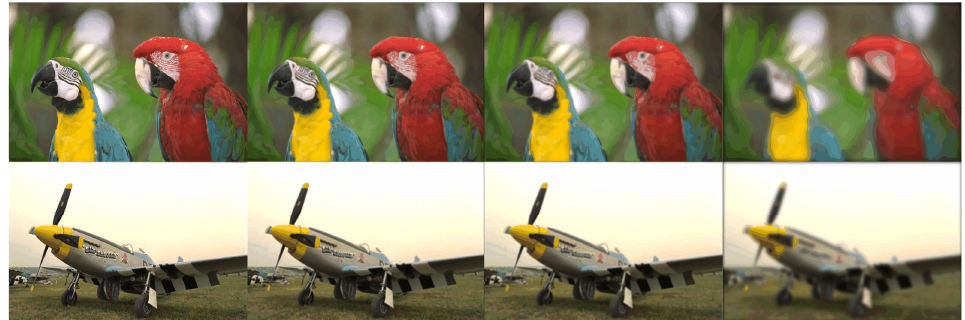
Figure 9. Gaussian blurred images.